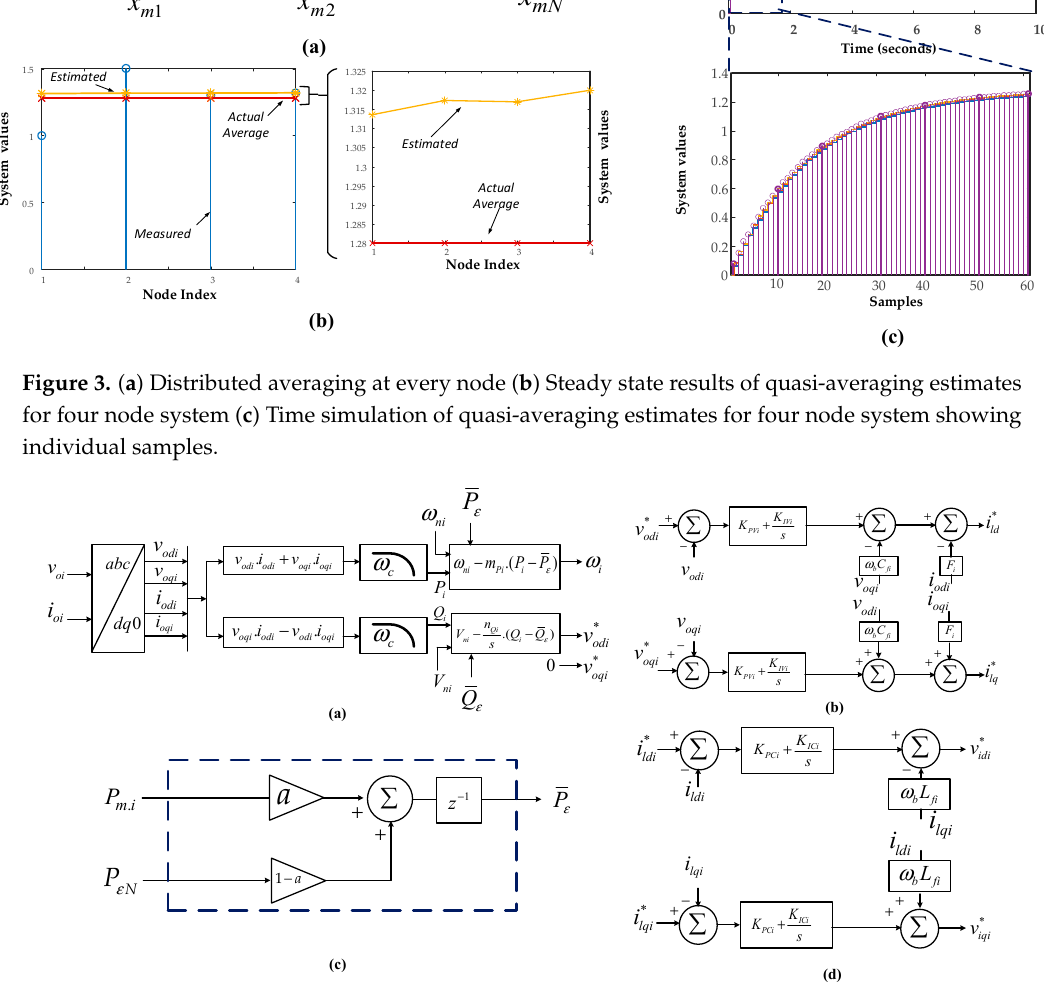
Figure 4. ( a ) Power controller ( b ) Voltage control loop ( c ) Distributed power quasi-averaging estimator ( d ) Current control loop.